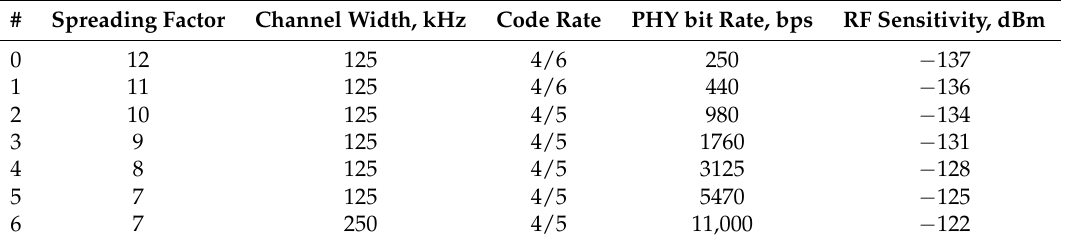
Table 1. Modulation and coding schemes (MCSs) in EU 863-780 MHz ISM